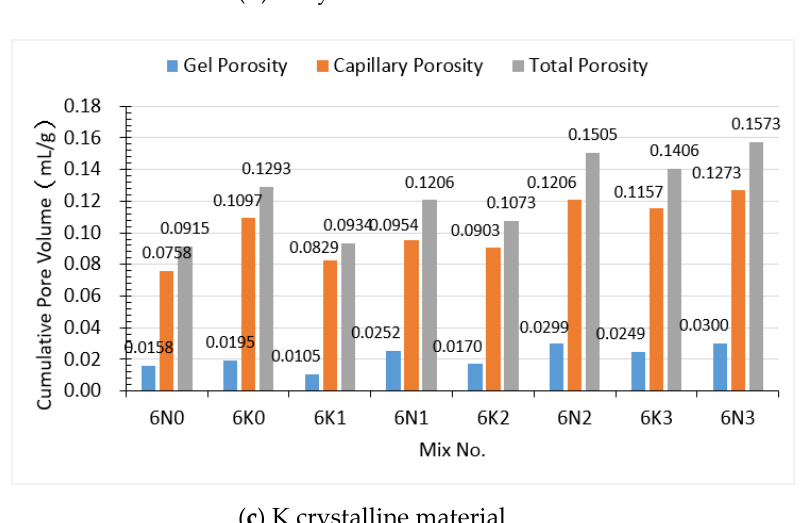
Figure 15. Pore relationships of cement mortar when W/C = 0.6 after 56-day curing.